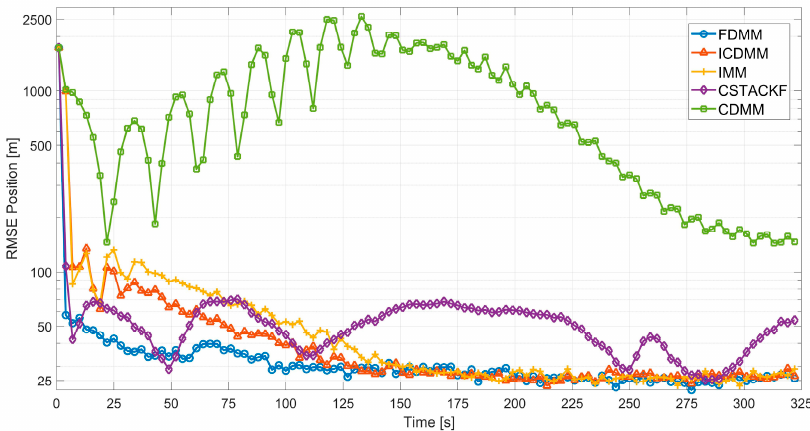
Figure 11. The comparison of position RMSE for different algorithms in Case 2.